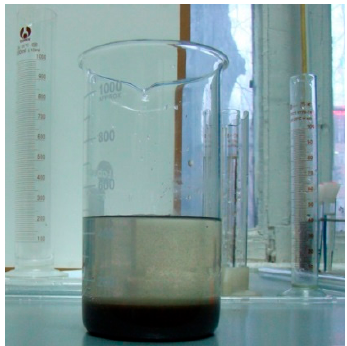
Figure 6. Deposition of electro erosion powder after sampling.